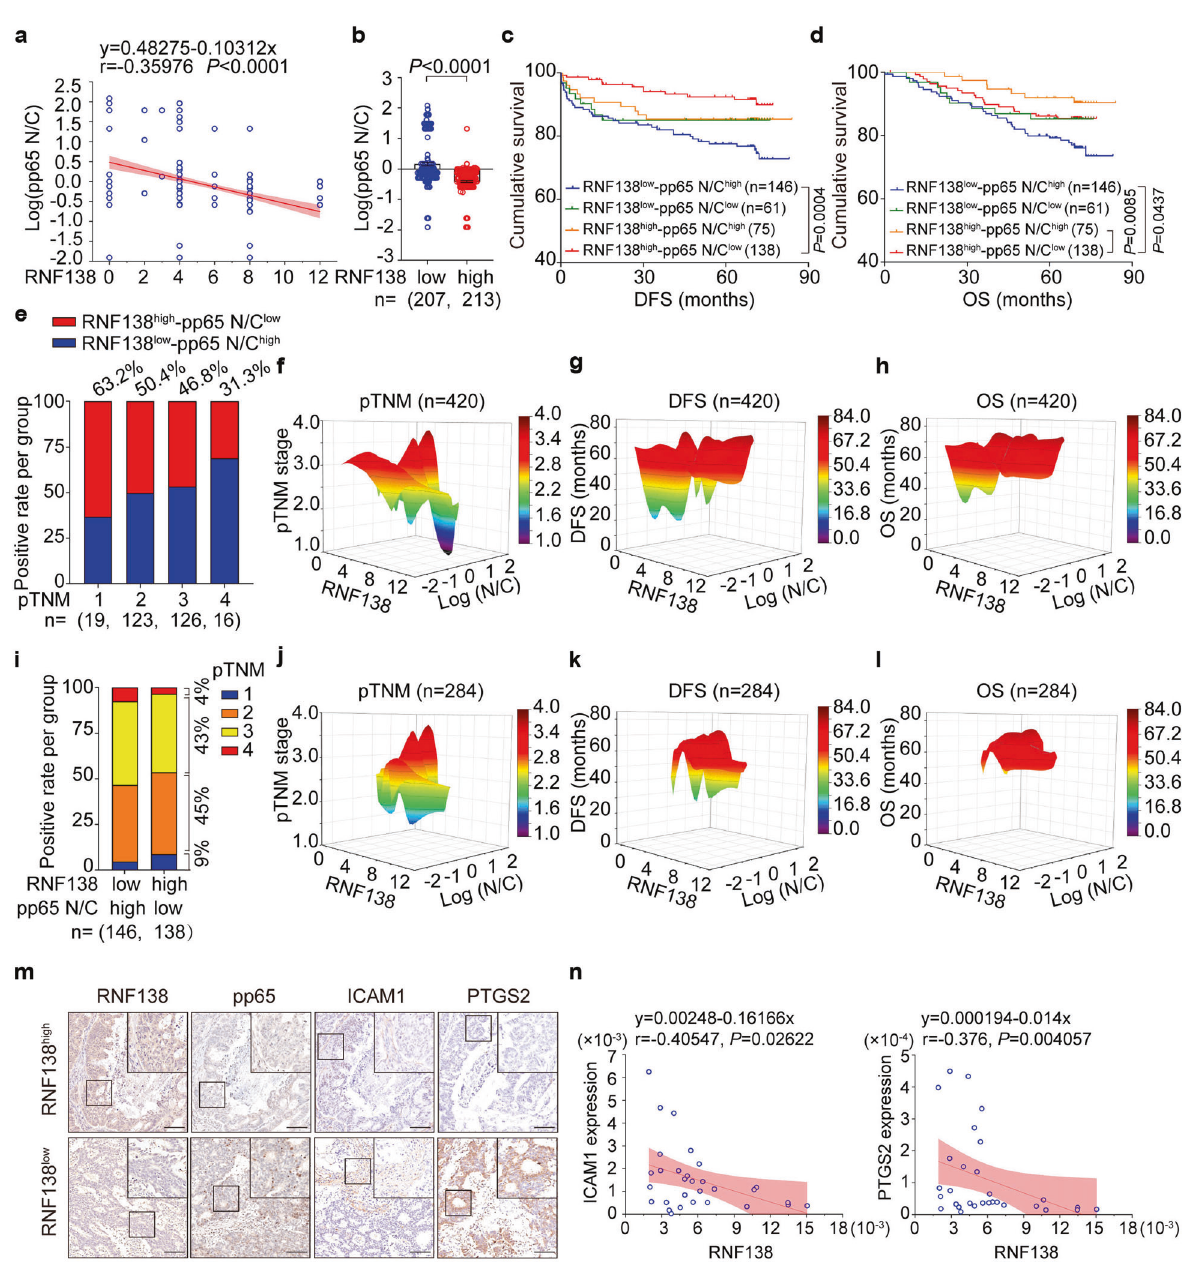
Fig. 6 RNF138 reduction coincided with aberrant activation of NF- к B signaling and correlated with unfavorable clinical outcomes in the CRC patients. a Correlation between log(pp65 N/C) and RNF138-staining according to Pearson ’ s test. The formula, coef fi cient of correlation (r), and the P value are indicated ( n = 420). b Assessment of log(pp65 N/C) expression levels in low ( n = 207) and high ( n = 213) RNF138 CRC tissues. Data are mean ± SEM. Kaplan – Meier survival curves of DFS ( c ) and OS ( d ) strati fi ed by RNF138 and pp65 N/C expression in CRC TMAs ( n = 420). Log-rank test was used. e Percentages of RNF138 high -pp65 N/C ratio low (red) and RNF138 low -pp65 N/C ratio high (blue) according to pTNM stage (1, 2, 3, 4) ( n = 284). Correlation among RNF138, log(pp65 N/C), and pTNM stage ( f ), DFS ( g ), and OS ( h ) in CRC patient TMAs ( n = 420). Log(N/ C) indicates log(pp65 N/C). i Percentages of pTNM stage in RNF138 high -pp65 N/C ratio low ( n = 138) and RNF138 low -pp65 N/C ratio high (n = 146) in CRC patient TMAs ( n = 284). Correlation among RNF138, log(pp65 N/C), and pTNM stage ( j ), DFS ( k ), and OS ( l ) in CRC patient TMAs ( n = 284). Log(N/C), log(pp65 N/C). m IHC analysis of pp65, ICAM1, and PTGS2 in low- and high-RNF138-expressing CRC samples. Scale bar, 100 μ m. n Correlation between RNF138 mRNA levels and NF- κ B target genes according to qPCR analysis. The formula, coef fi cient of correlation (r), and the P value were provided via Pearson ’ s test ( n = 30) hyperactivation of NF- κ B (high pp65 N/C ratio). Critically, this the transition from colitis to tumor and sensitized the CRC cells clinical index was associated with a signi fi cant proportion to SC75741, a highly potent and speci fi c NF- κ B signaling (~34.8%, [146/420]) of CRC patients in our cohort, and with inhibitor. More importantly, this notion was further supported poorer prognoses compared with the rest of the cohort. This by the observations in the CDX and PDX models, highlighting prompts us to wonder the possibility that low RNF138 and high the potential of SC75741 in speci fi c NF- κ B-targeting therapy for pp65 N/C ratio in combination can be utilized as a useful treating the CRC patients with low RNF138 expression and Signal Transduction and Targeted Therapy (2022)